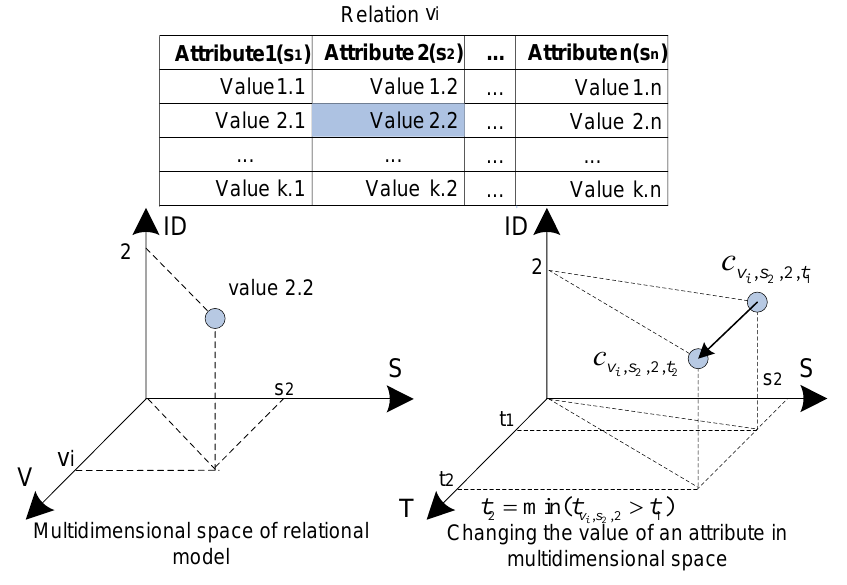
Fig. 3. Relational and multidimensional data